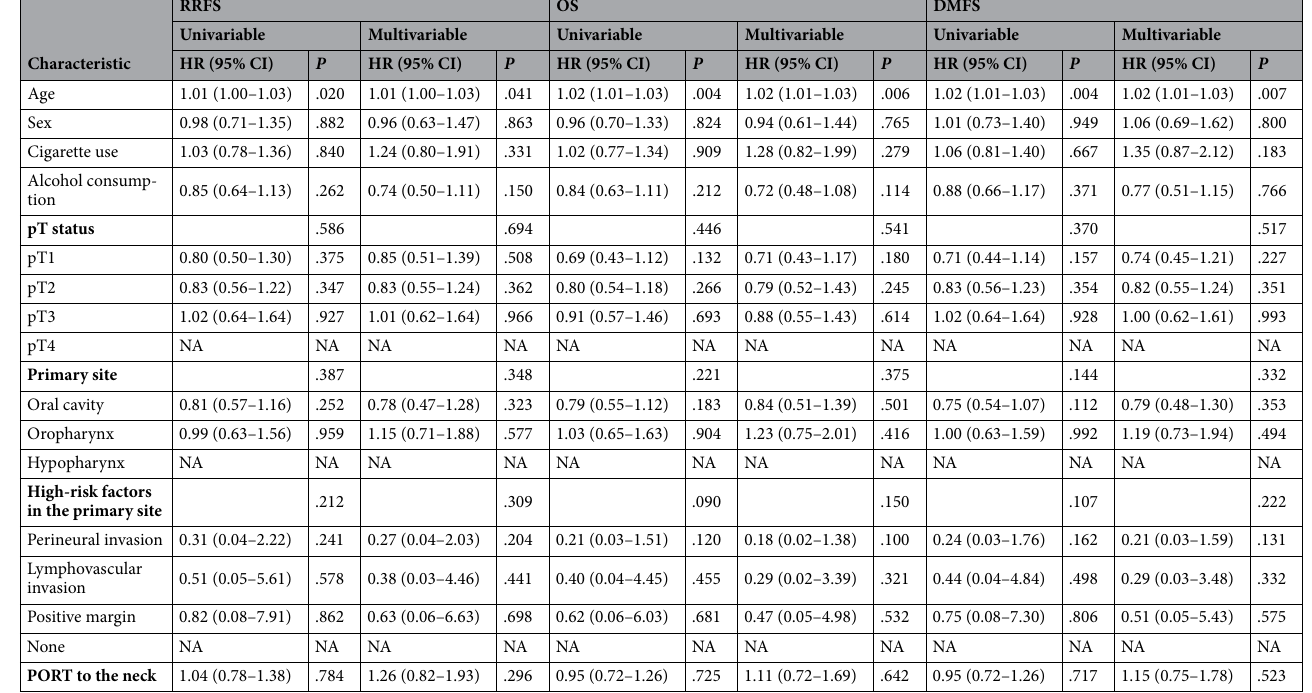
Table 4. Cox proportional hazards regression analysis of survival in all 208 patients. RRFS regional recurrence-free survival, OS overall survival, DMFS distant metastasis-free survival, pT status pathologic tumor status, HR hazard ratio, CI confidence interval, NA not